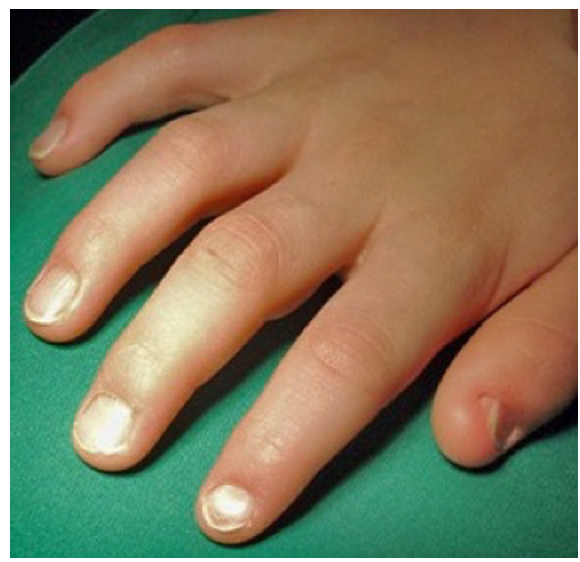
Figure 1. Typical hypoplastic finger nails in a six-year-old boy with nail-patella-syndrome. Note the decreasing pathology from first to fifth